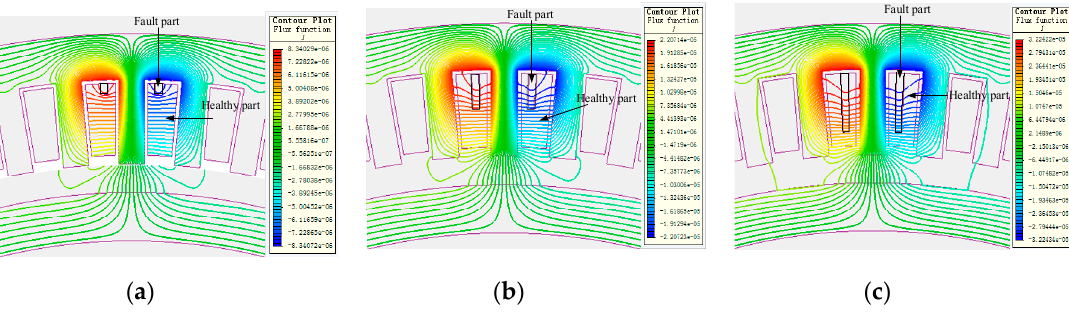
Figure 9. The flux density distributions when different numbers of turns are shorted in layer 2: ( a ) two turns shorted; ( b ) six turns shorted; ( c ) 10 turns shorted.